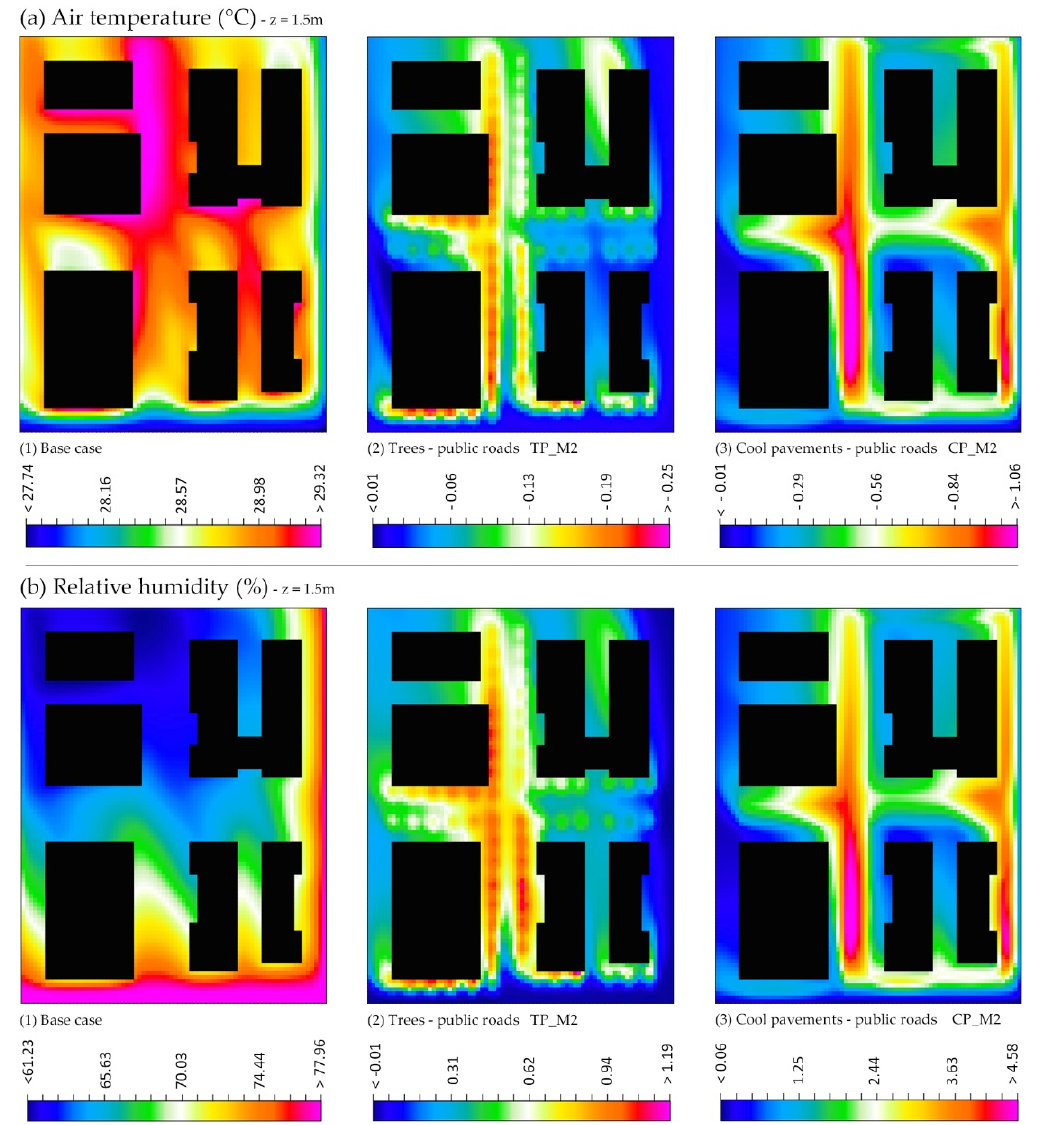
Figure 8. Distribution of the outdoor air temperature and the relative humidity for the base case ( a.1 and b.1 , respectively) and the map related to both parameters illustrating the difference between the base case and the two different redevelopment measures considered: introduction of the trees in the public roads and the use of cool pavements in the public